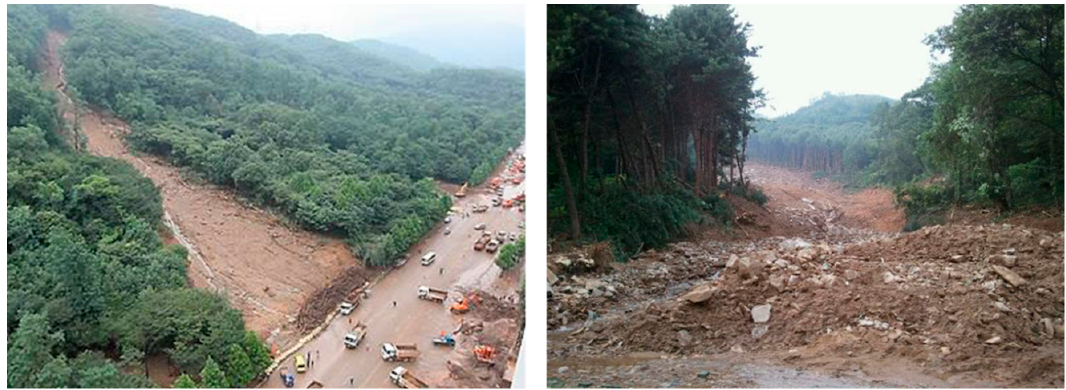
Figure 3. Landslide status on the northern side of Mt. Umyeon in 2011 [39,40].